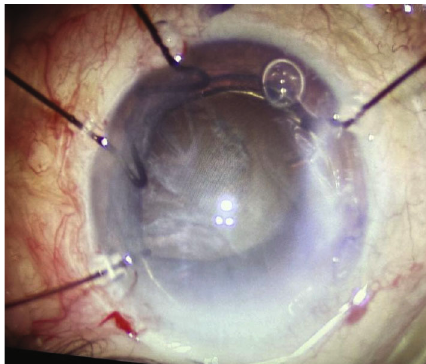
Figure 4: After the capsular tension ring was implanted, a single- piece foldable intraocular lens was implanted into the